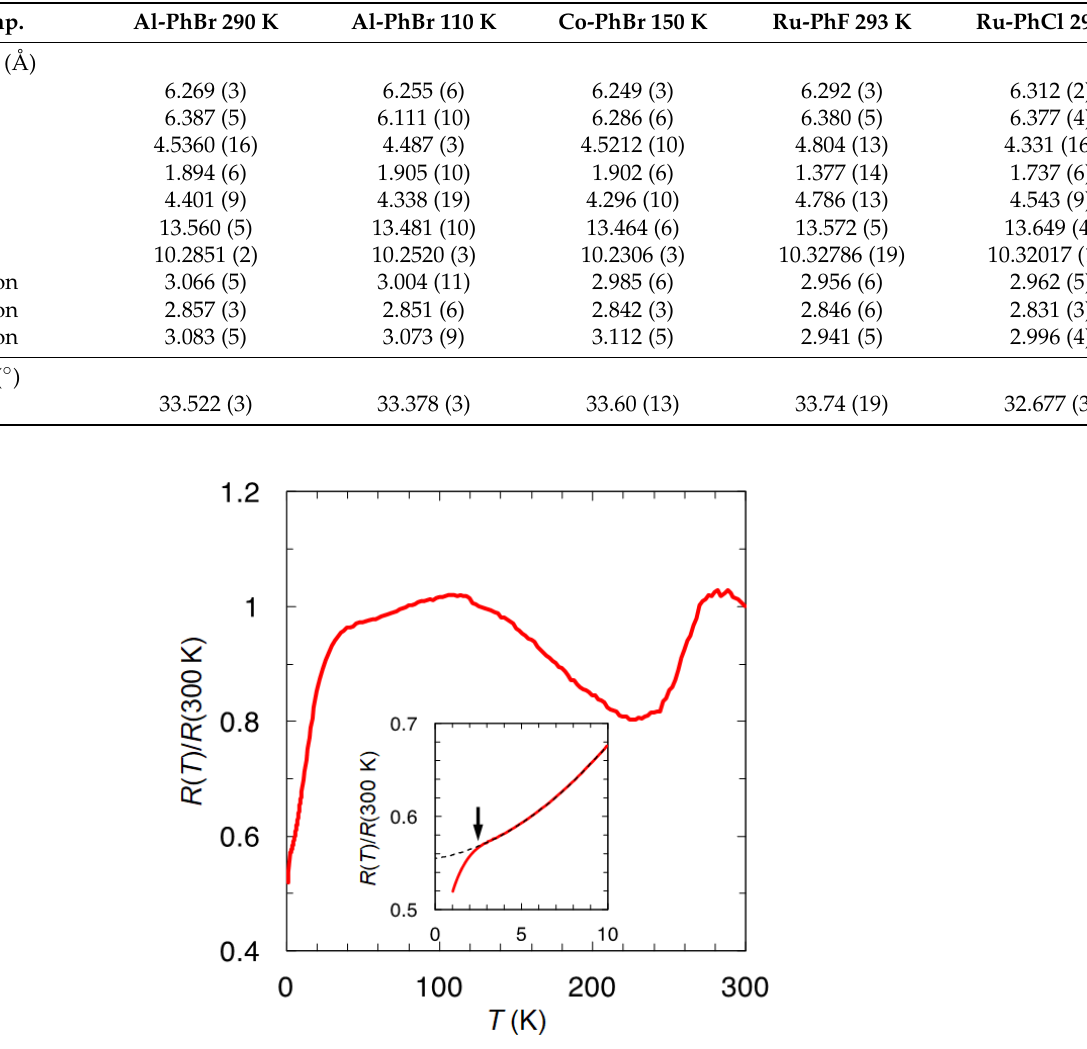
Figure 4. Electrical resistivity for Al-PhBr .